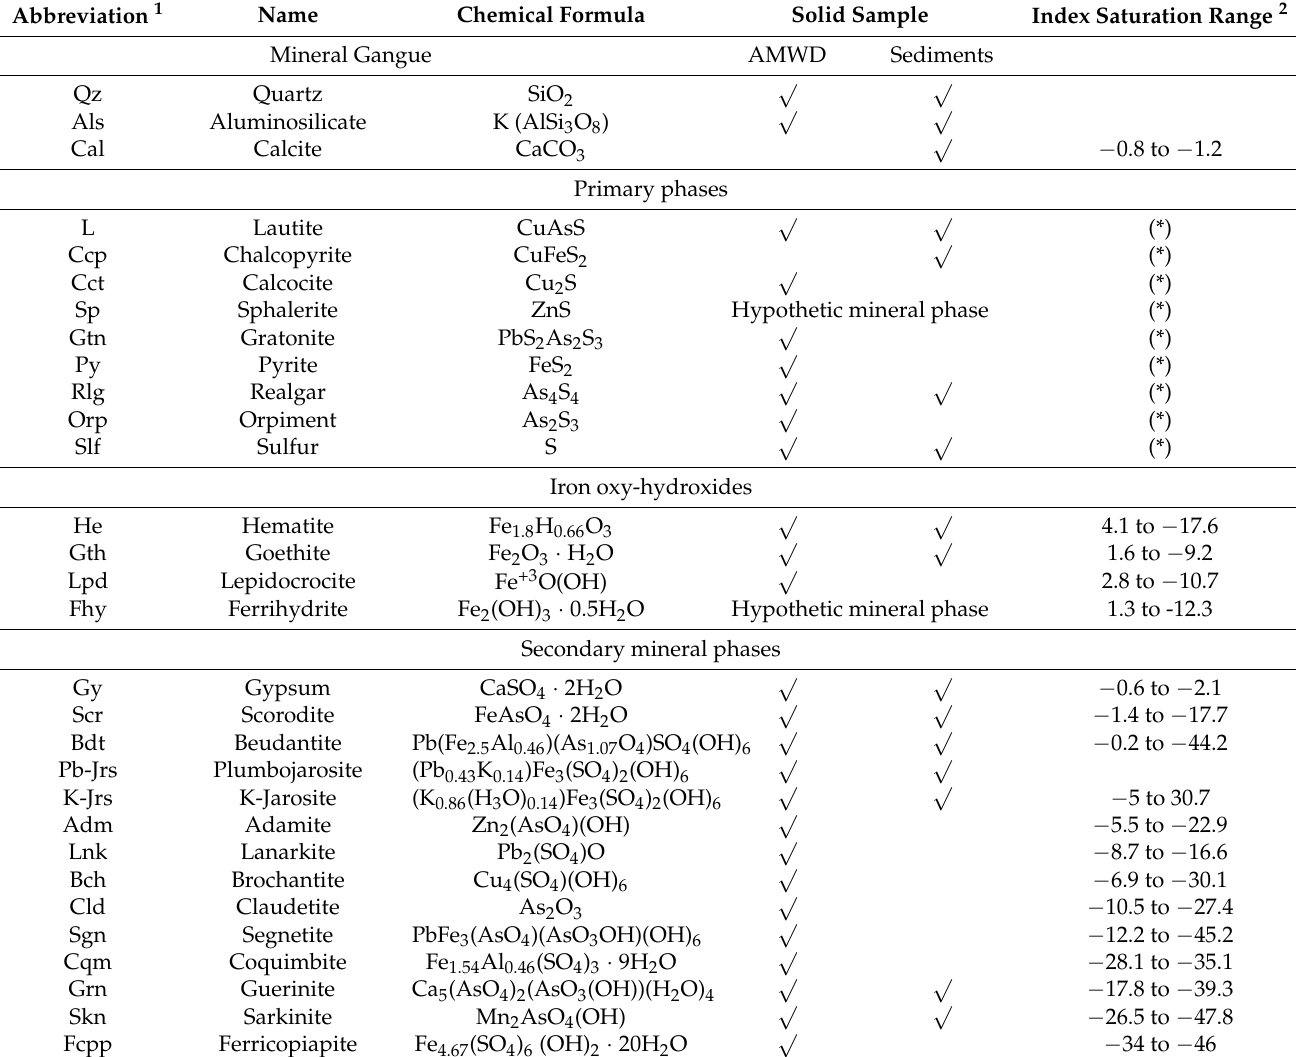
Table 3. Mineral phases present in the samples from the study